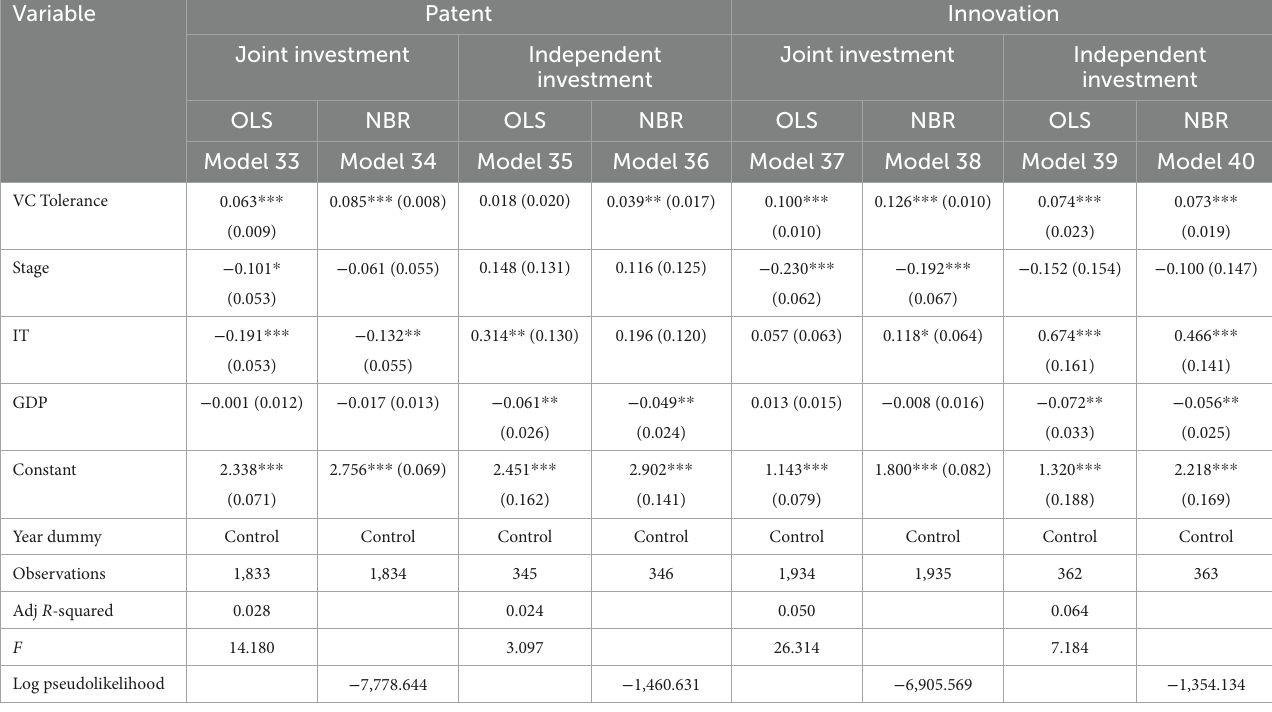
TABLE 8 Regression results of the moderating effect of joint investment on the relationship between VC failure tolerance and enterprise innovation performance.